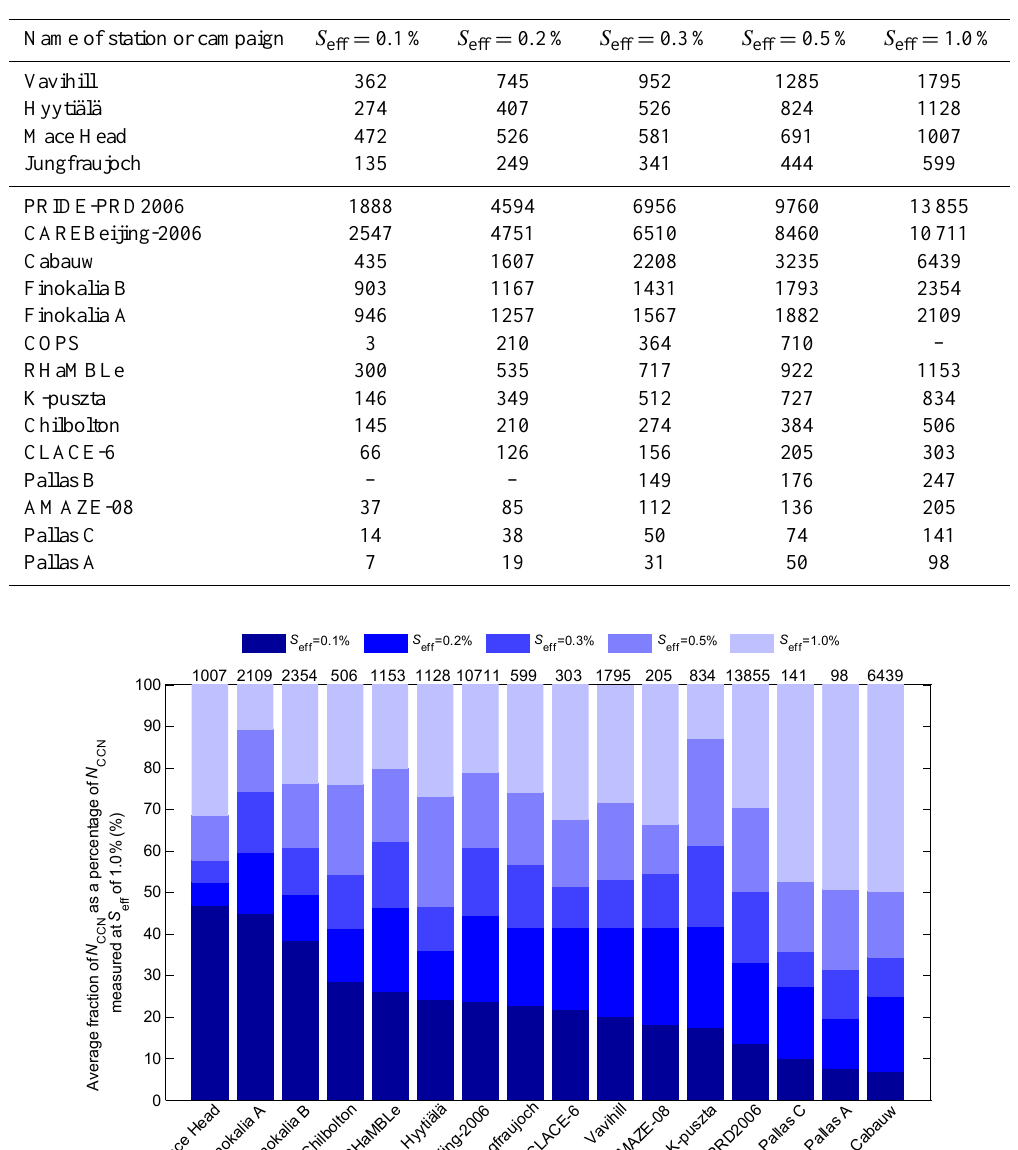
Table 3. Average N CCN concentrations (cm − 3 ) at all studied locations. All N CCN concentrations were recalculated to correspond to the S eff levels suggested by the ACTRIS network: 0.1, 0.2, 0.3, 0.5 and 1.0%. The four long-term data sets are shown at the top of the table.